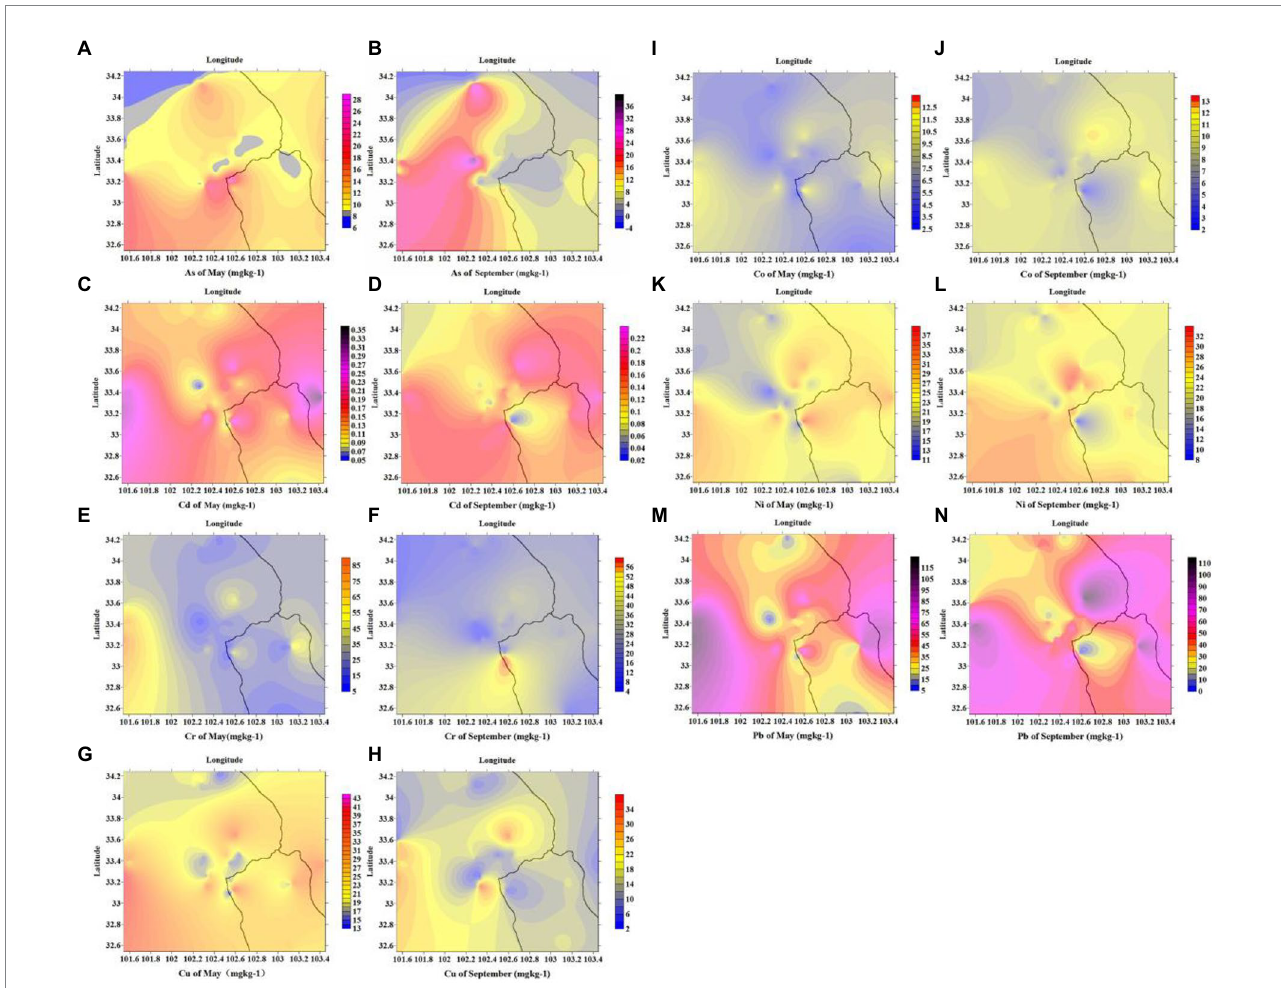
FIGURE 3 Spatial distribution of the topsoil heavy metals of As (A,B) , Cd (C,D) , Cr (E,F) , Cu (G,H) , Co (I,J) , Ni (K,L) and Pb (M,N) . (The blue and yellow areas indicate that the metal concentrations were lower than the background values ( BV ); the red area denotes concentrations between 1 BV and 2 BV ; the purple areas indicate concentrations between 2 BV and 3 BV ; and the black area represents concentrations equal to or greater than 3 BV